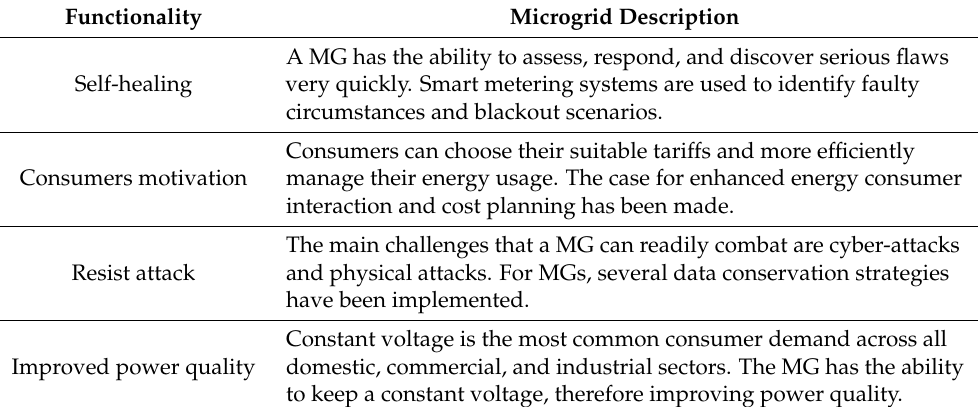
Table 2. Primary capabilities of a